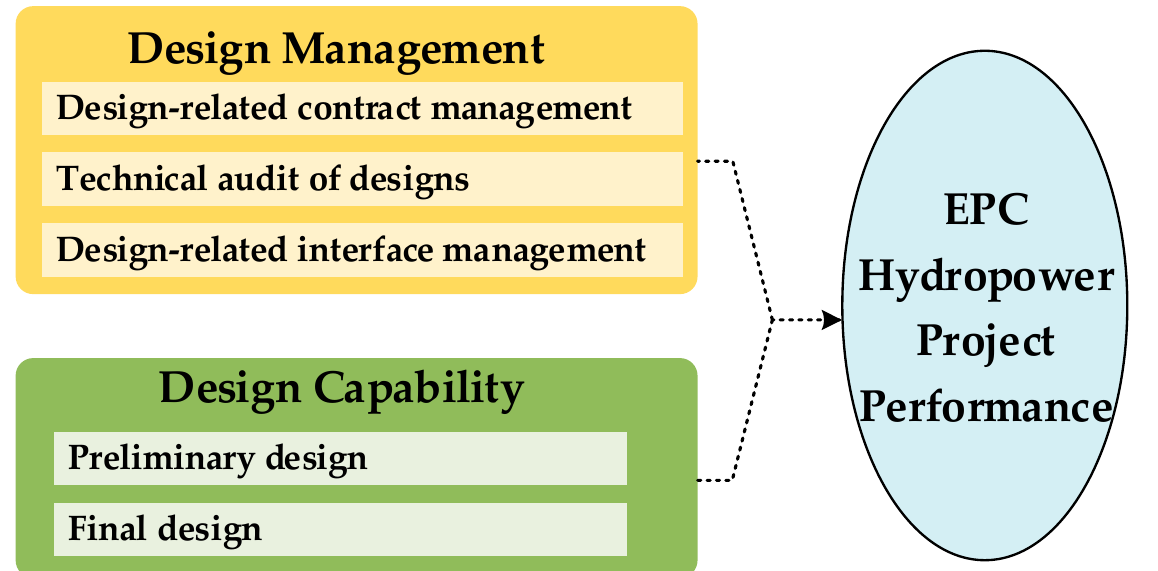
Figure 6. Impacts of design management and design capability on EPC hydropower project perfor- mance.